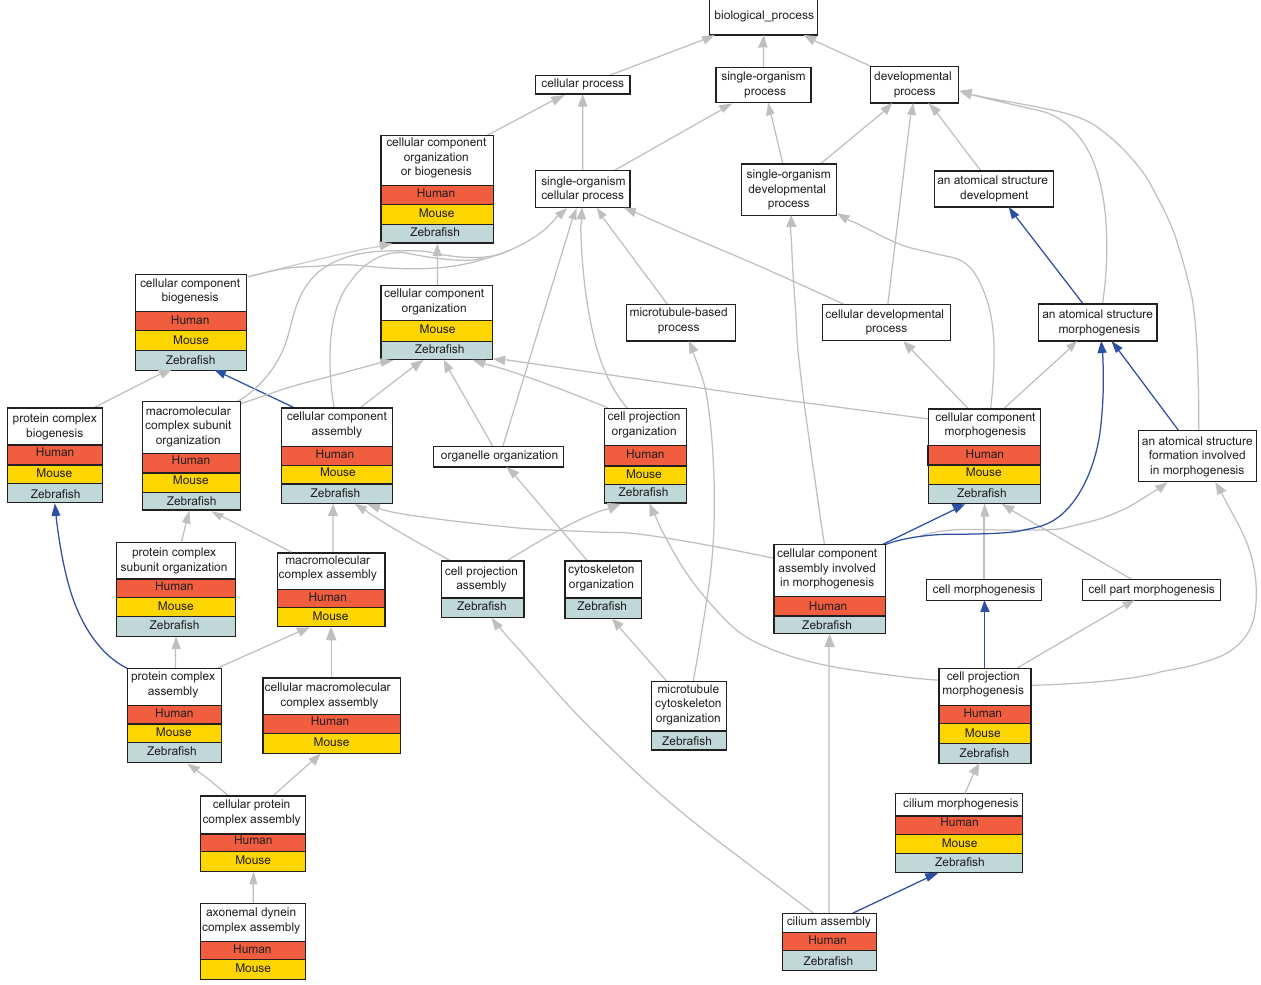
Figure 1. View of relationships between enriched terms from the cellular component organization or biogenesis ontology. The GONUTs view of relationships between enriched terms from the cellular component organization or biogenesis ontology 84 . The grey arrows are used where a term has an ‘is a’ relationship to its parent term, the blue arrows indicate a ‘part of’ relationship. The bars below each GO term indicates which of these terms are enriched in the zebrafish ‘jogging’ gene list, and the human and mouse ‘jogging ortholog’ gene